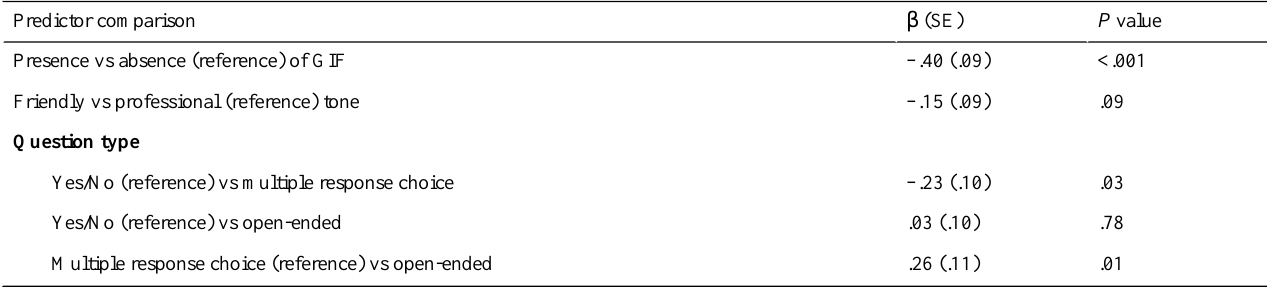
Table 1. Ordinal logistic regression for factors associated with perceived emotional valence (N=19).